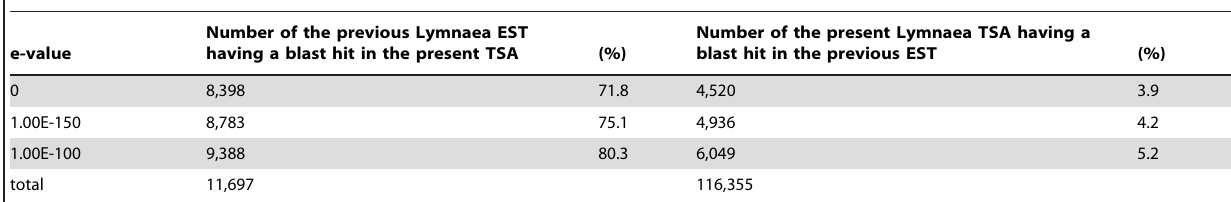
Table 3. Comparison of the present Lymnaea TSA and the previously reported Lymnaea EST.